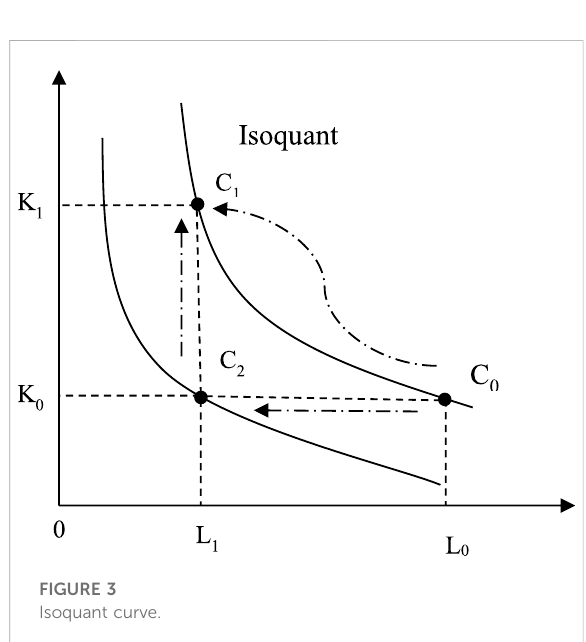
FIGURE 3 Isoquant